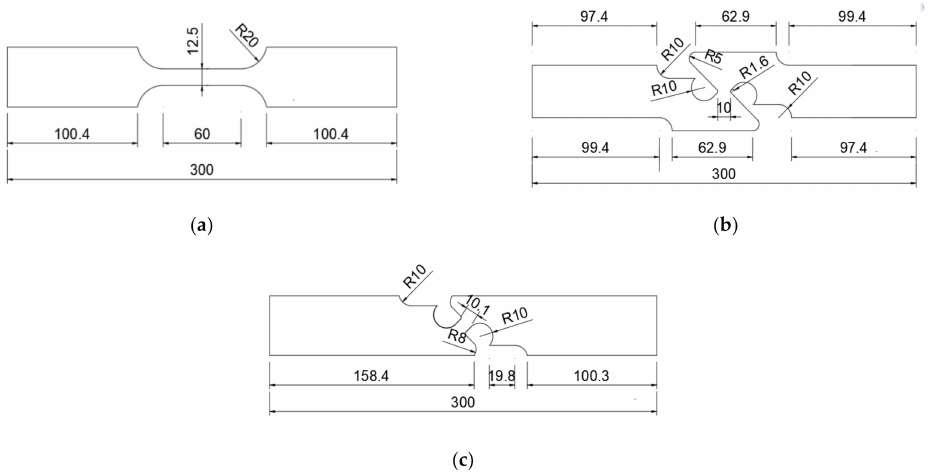
Figure 1. Configuration of the test specimens (dimensions in mm): ( a ) Uniaxial tension specimen; ( b ) In-plane shear specimen; ( c ) Tension and shear